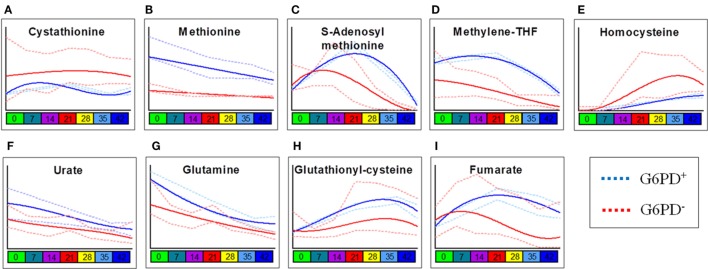
Most significant metabolic differences between glucose 6-phosphate dehydrogenase (G6PD) sufficient and deficient red blood cells (RBCs). Panels indicate alterations to sulfur/one-carbon metabolism (A–E), purine oxidation (F), glutathione homeostasis (G,H), and carboxylates (I) in G6PD sufficient (blue line) and deficient (red line) RBCs during storage in the blood bank (median + ranges are shown in light blue or red for both G6PD sufficient and deficient groups, respectively).